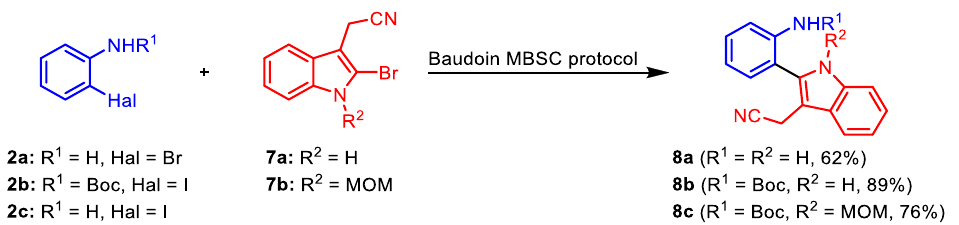
Figure 6. Synthesis of analogues of rhazinilam 5 via Baudoin’s one -pot MBSC protocol [34].